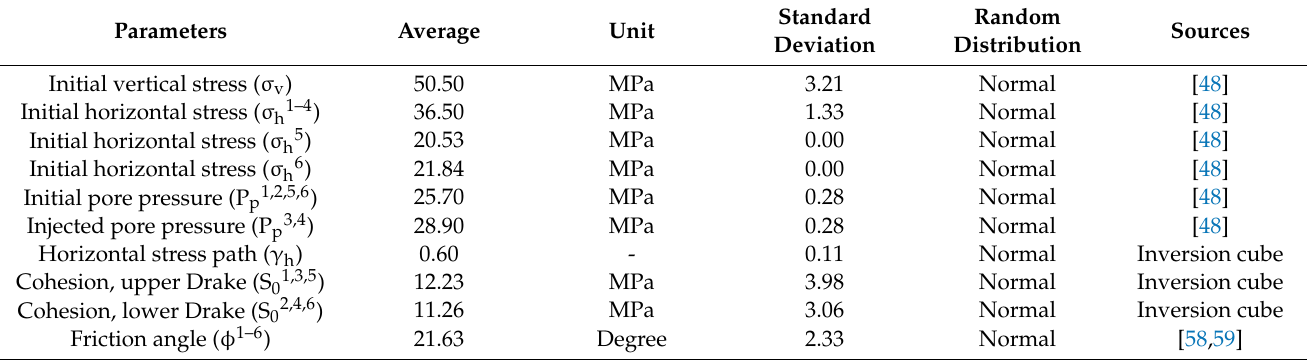
Table 2. The average and standard deviation of the model input parameters are presented with the type of distribution and data sources. Please note that the superscript numbers in the property names represent the case numbers explained in Table